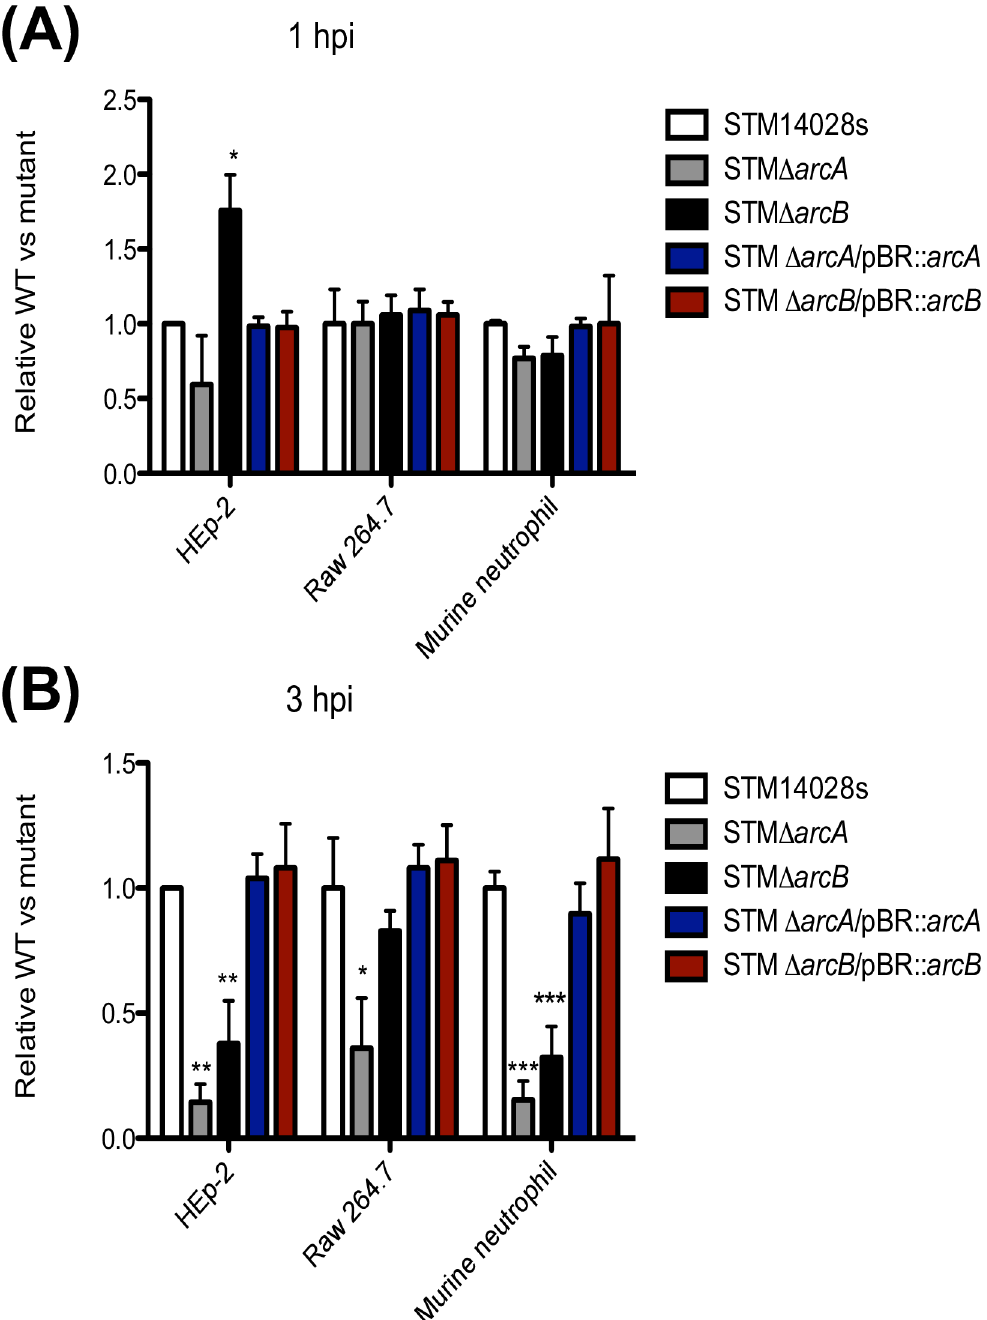
Fig 1. Relative CFUs harvested from mutant vs. wild type S . Typhimurium strains. Strains from S . Typhimurium were incubated at a MOI of 100 with HEp-2, RAW 264.7 and bone-marrow derived neutrophils. Intracellular bacteria were harvested at 1 hpi (A) and 3 hpi (B) by lysing the cells with sodium deoxycholate. Values are the number of CFU from each strain relative to the number of CFU from the parental strain. Data represent mean ± SD from 5 independent experiments. (cid:3) P < 0.05; (cid:3)(cid:3) P < 0.01, (cid:3)(cid:3)(cid:3) P < 0.001 by one-way ANOVA followed by Bonferroni post hoc test.